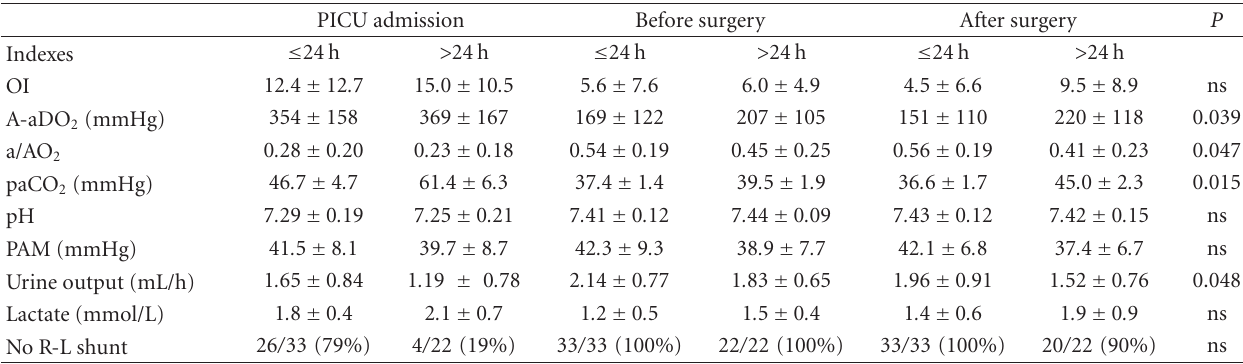
Table 2: Trend of respiratory, blood-gas-derived, hemodynamic, and metabolic indexes at the three considered times (PICU admission, before surgery, after surgery) in the 55 patients stabilized and submitted to surgery, divided into two groups according to the duration of preoperative stabilization stage ( ≤ 24 hours or > 24